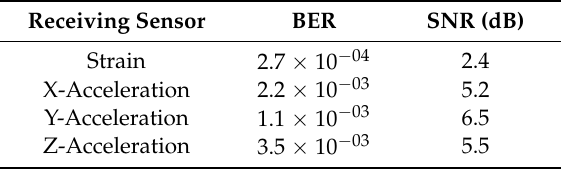
Table 1. Average BERs and SNRs of various receiving sensors, with one actuator transmitting one data stream.